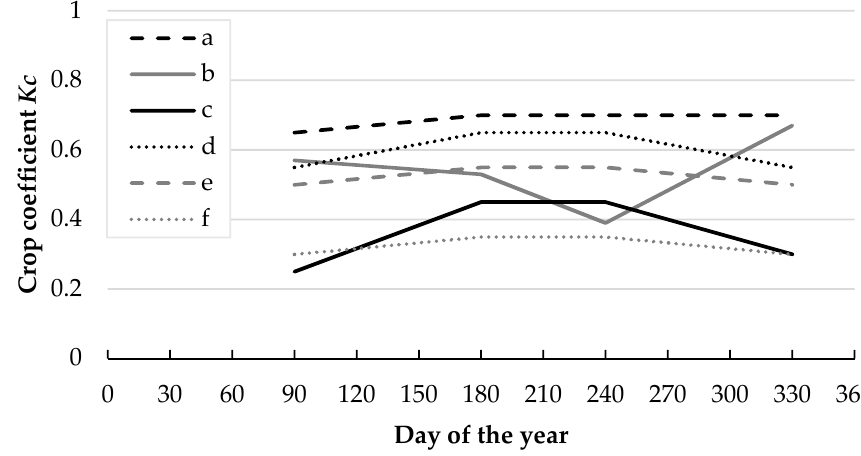
Figure 1. K c values from various sources: ( a ) [15], ( b ) [46], ( c ) HMA (1992), ( d ) [47]—High density, Figure 1. (cid:1837) (cid:3030) values from various sources: a) [15], b) [46], c) HMA (1992), d) [47]—High density, e) ( e ) [47]—Medium density, ( f ) [47]—Low density / [47]—Medium density, f) [47]—Low density/young.